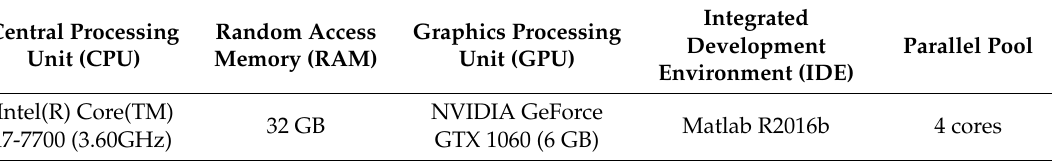
Table 2. Simulation experiment environment.